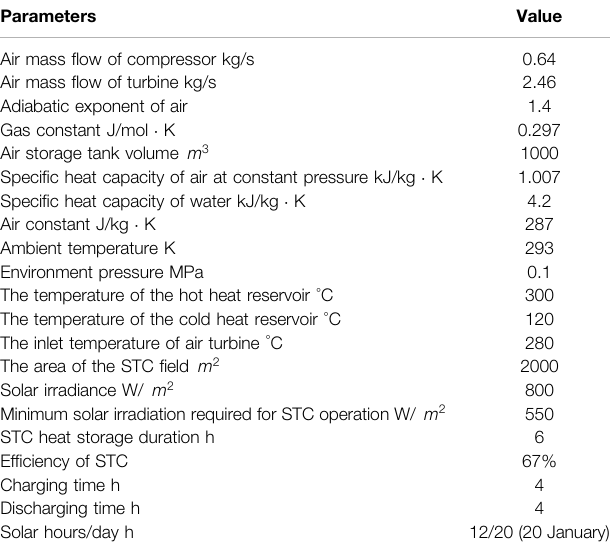
TABLE 1 | The rated parameters of the HA-CAES system.